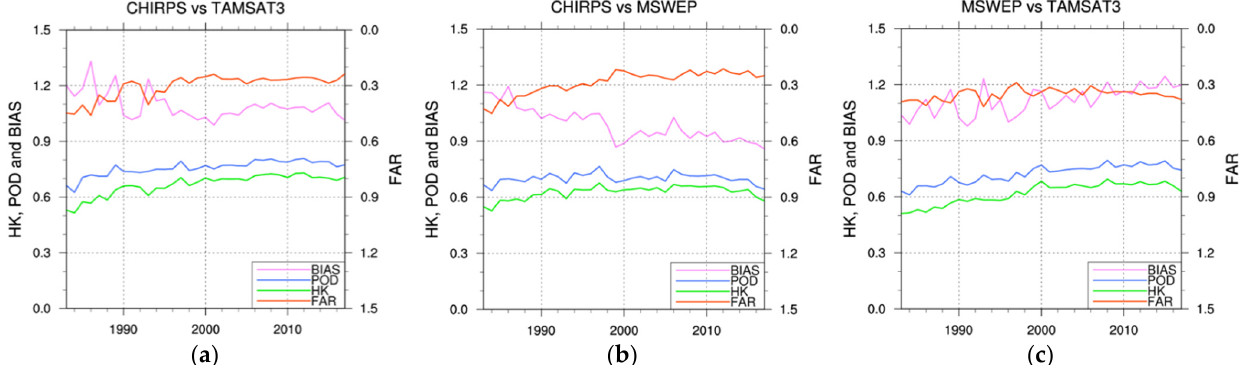
Figure 15. EA-averaged annual HK, POD, BIAS and FAR (right y-axis) for TAMSAT3 with respect to CHIRPS ( a ), MSWEP with respect to CHIRPS ( b ) and TAMSAT3 with respect to MSWEP ( c ).